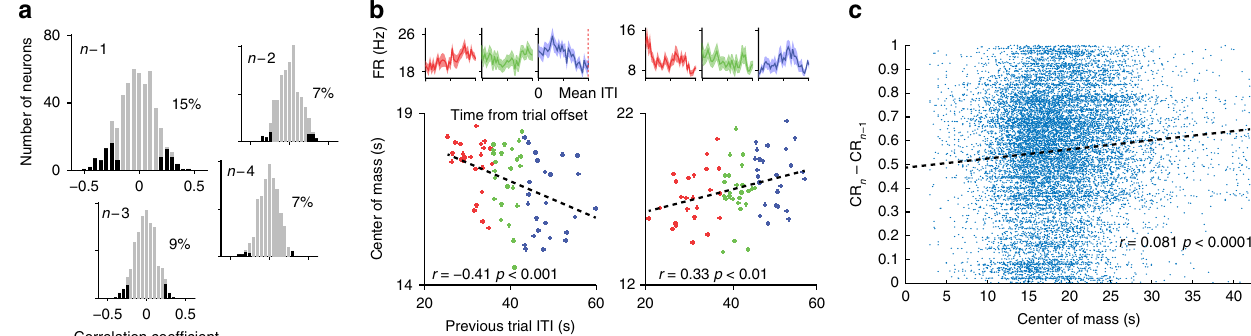
Fig. 5 ITI duration affects the temporal-tuning in the next trial. a The location of the preferred time is correlated with the duration of the previous trial ITI in 15% of all cells ( p < 0.01, binomial test). Earlier ITIs (trials n − 2/3/4) affect much less. b Two examples of cells in which the preferred time (quanti fi ed as center of mass, y -axis) correlates with the ITI duration of the previous trial ( x -axis). The PSTHs of the lower third (red), middle third (green), and upper third (blue) are shown on top. Data presented as mean ± S.E.M. c Change in CR amplitude between successive trials plotted against the center of mass of neural activity in the ITI between the trials. Shown are all single units in all trials they were recorded, together with the linear fi t. n days = 82; single units: amygdala: n = 291; dACC: n = 263 NATURE COMMUNICATIONS| (2018) 9:4460 |DOI: